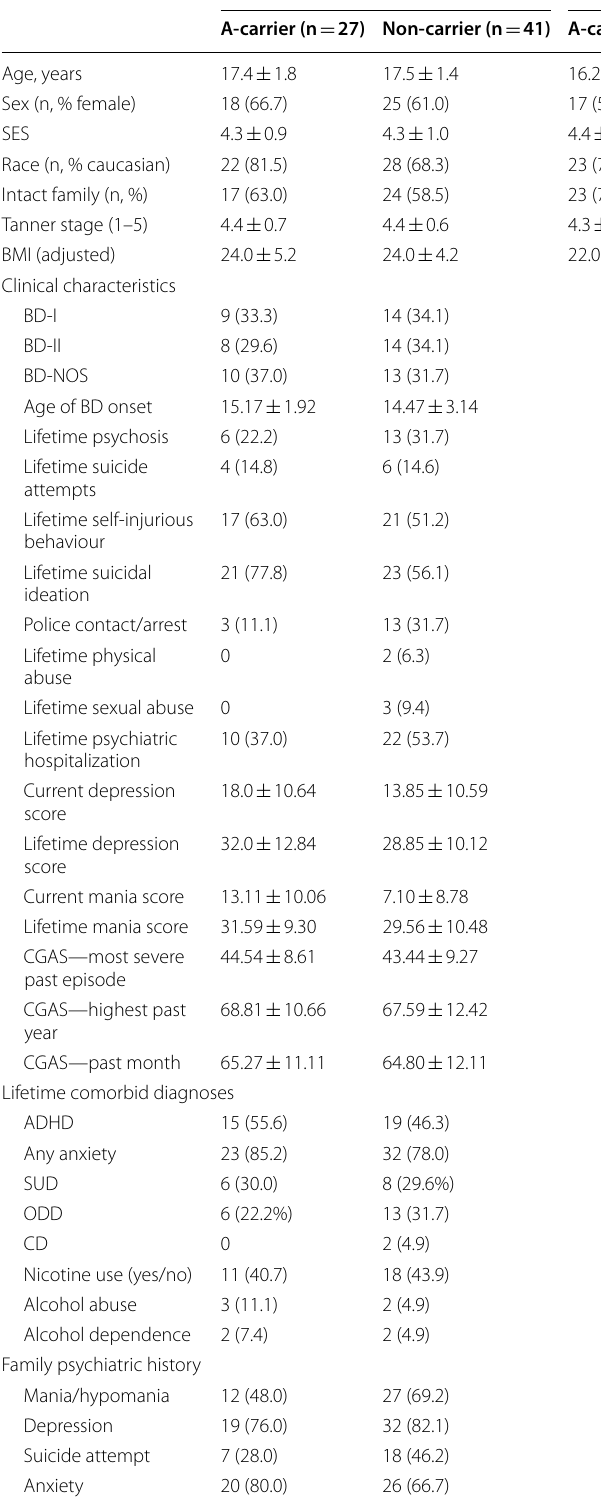
Table 1 Demographic and clinical characteristics BD HC Test statistic p -value Effect